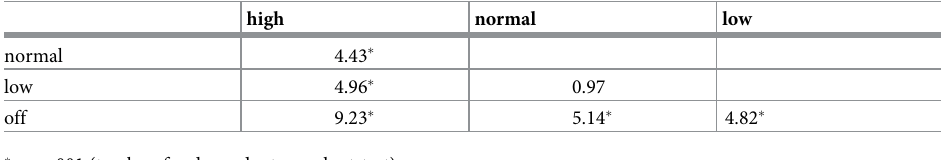
Table 1. Pairwise comparisons for each level of grunt